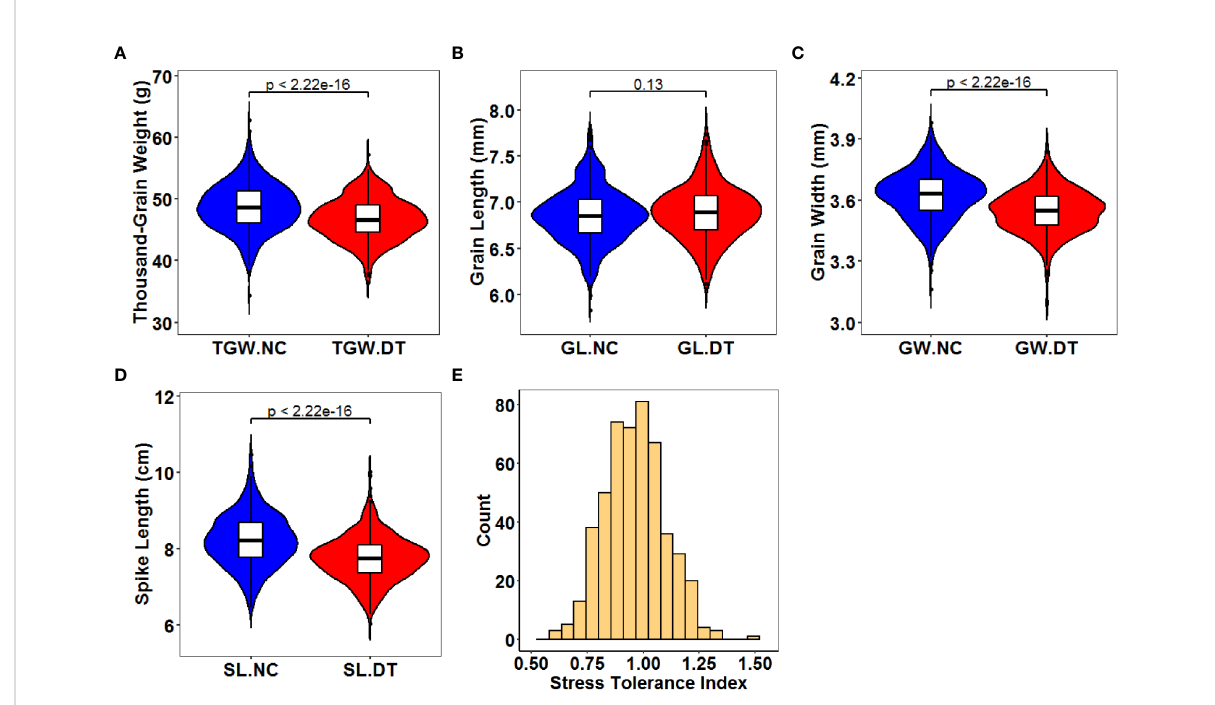
FIGURE 1 Distribution of the average phenotype for the 502 wheat accessions across all environments. (A) Thousand-grain weight under normal (TGW.NC) and drought treatment conditions (TGW.DT); (B) Grain length under normal (GL.NC) and drought treatment conditions (GL.DT); (C) Grain width under normal (GW.NC) and drought treatment conditions (GW.DT); (D) Spike length under normal (SL.NC) and drought treatment conditions (SL.DT); (E) Stress tolerance index. The center and edges of the boxplot represent the median and the 25th or 75th percentile respectively, while the whiskers represent the median ± 1.5 × IQR (interquartile interval).